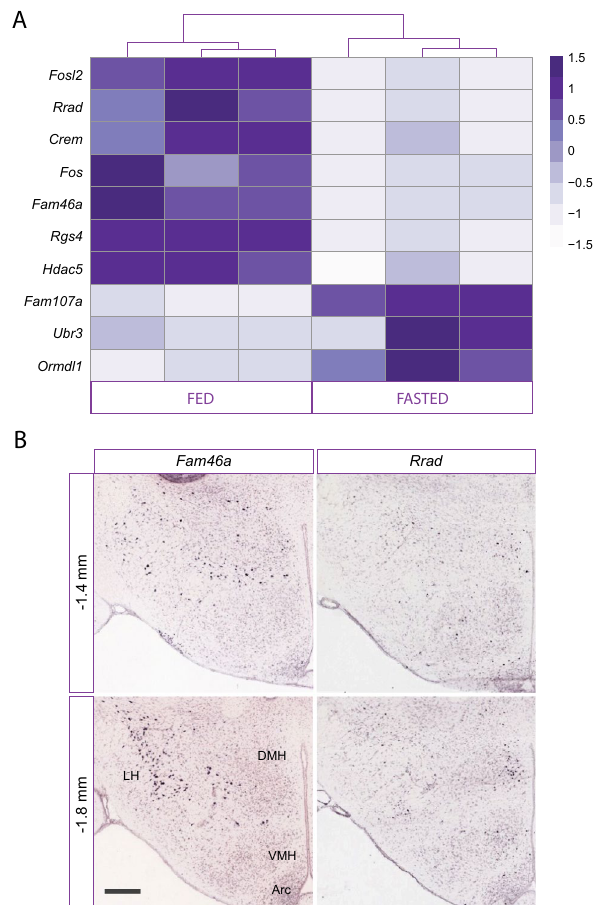
Figure 4. Genes differentially regulated by fasting ( A ) Heatmap of ten (10) genes that were differentially regulated by 24-h fasting (adjusted p < 0.05, n = 3 samples/condition). ( B ) Representative images of in situ hybridization (ISH) stainings for Fam46a and Rrad in the mouse hypothalamus (bregma points − 1.4 and − 1.8 mm) from the Allen Brain Atlas